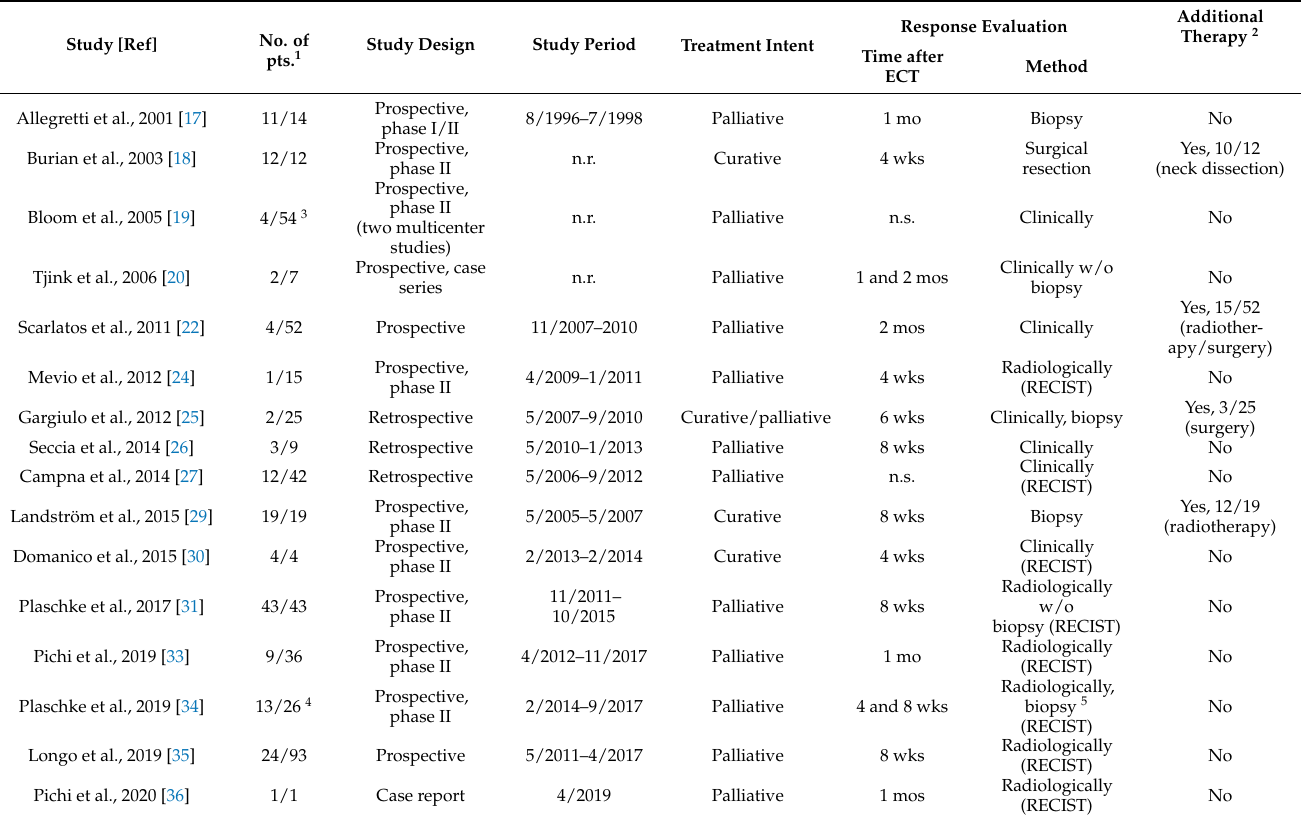
Table 1. Summary of the characteristics of the included studies.